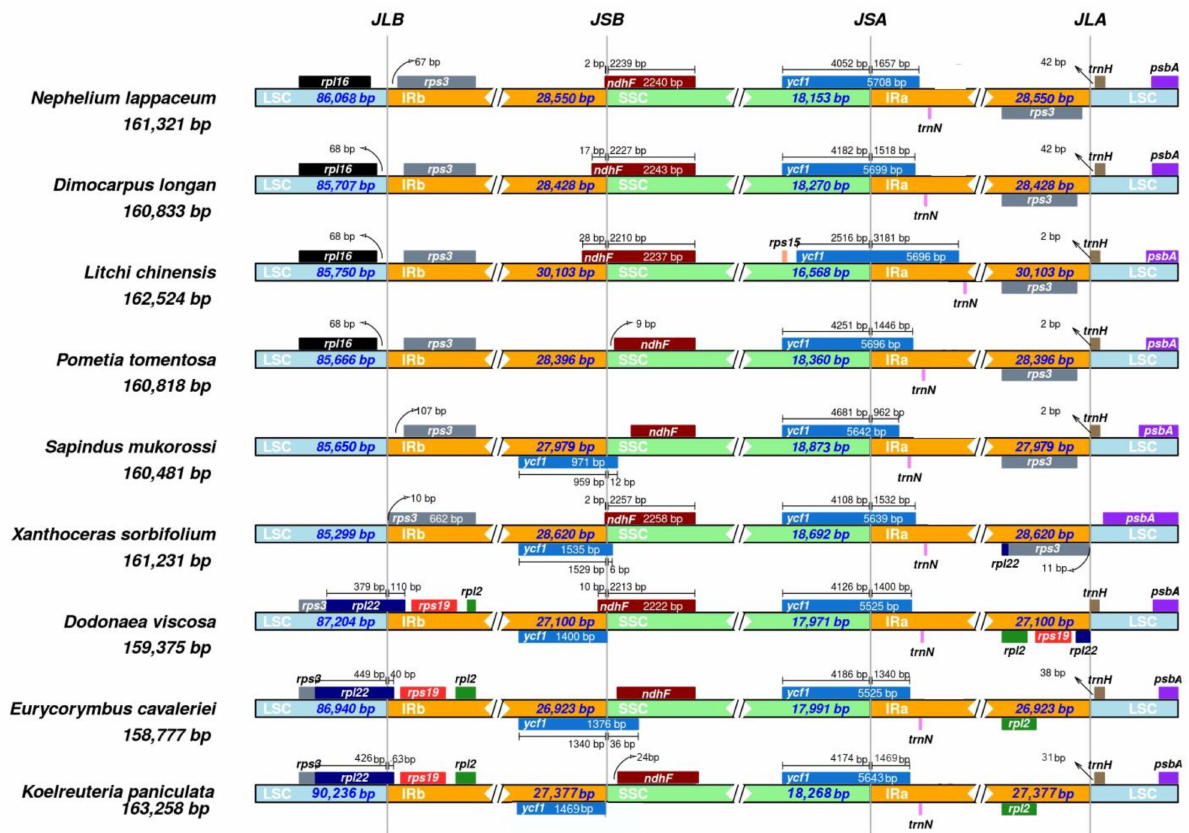
Figure 5. Comparison of the borders of the LSC, SSC and IR regions among nine Sapindaceae chloroplast genomes. For each species, genes transcribed in positive strand are depicted on the top of their corresponding track from right to left direction, while the genes on the negative strand are depicted below from left to right. The numbers at arrows refer to the distance of the start or end position of a given gene from the corresponding junction site. The T bars above or below the genes indicate the extent of their parts with their corresponding values in the base pair. The plotted genes and distances in the vicinity of the junction sites are the scaled projection of the genome. JLB (IRb /LSC), JSB (IRb/SSC), JSA (SSC/IRa) and JLA (IRa/LSC) denote the junction sites between each corresponding two regions of the